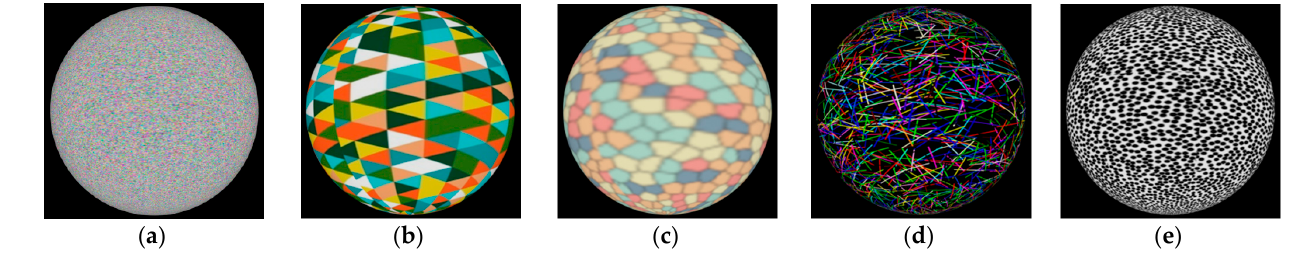
Figure 2. Example of the sphere with rendered texture used for final validation: ( a ) RGB noise (ran- dom colours), ( b ) colour triangles, ( c ) stained glass, ( d ) random colour line segments, and ( e ) ran- dom black points.